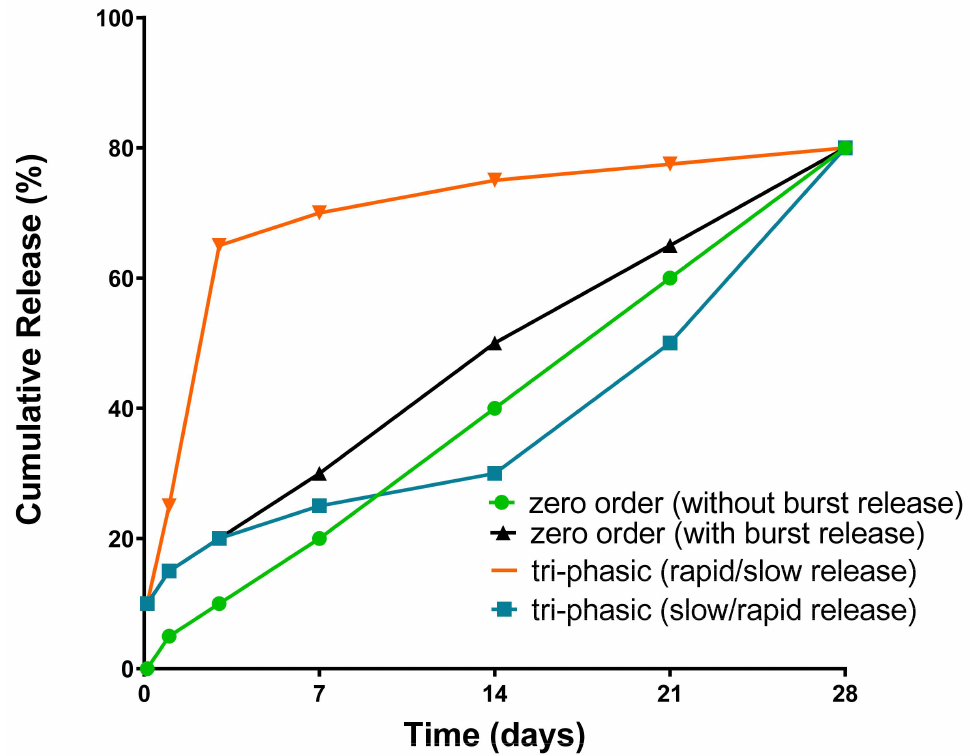
Figure 10. Schematic diagram showing typical drug release profiles over a 28-day period. The green and black lines show zero order drug release with and without initial burst release respectively. The orange line shows rapid phase 2 and slow phase 3 release, whereas the blue line shows slow phase 2 release followed by rapid phase 3 release (modified from Fredenberg., et al., 2011